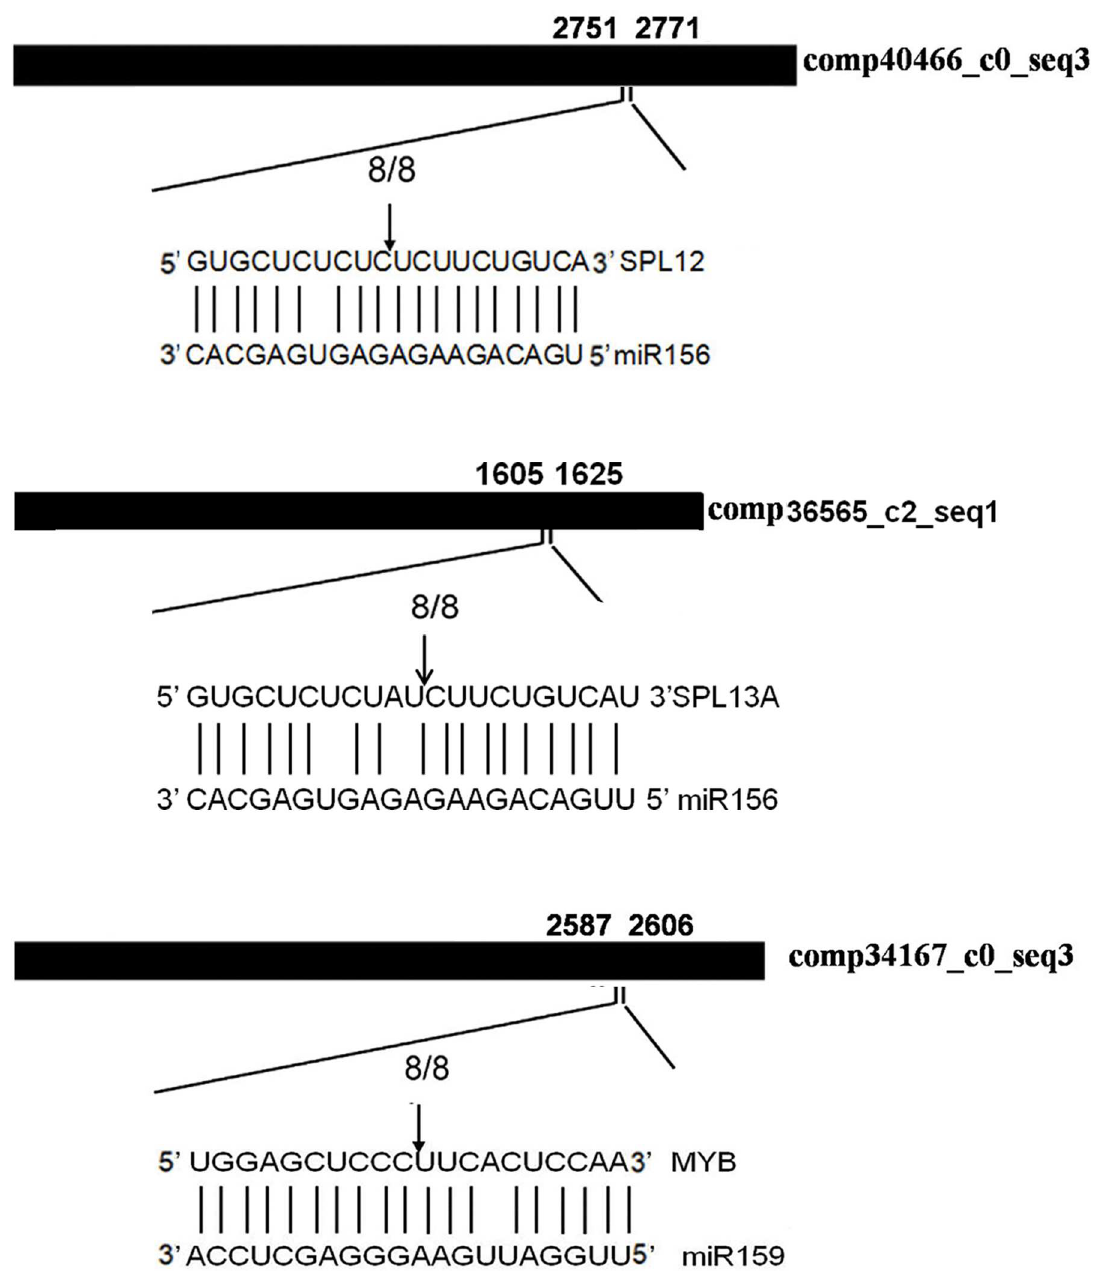
Fig 5. Experimental validation of the miRNA targets. Cleavagesites were determined by the modified 5’RNA ligase- mediatedRACE. Heavy black lines represent unigenes.miRNA complementary sites with the nucleotide positions of SPL and MYB cDNAs are indicated. Vertical arrows indicate the 5’ termini of miRNA-guided cleavageproducts, as identifiedby 5’- RACE, with the frequencyof clones